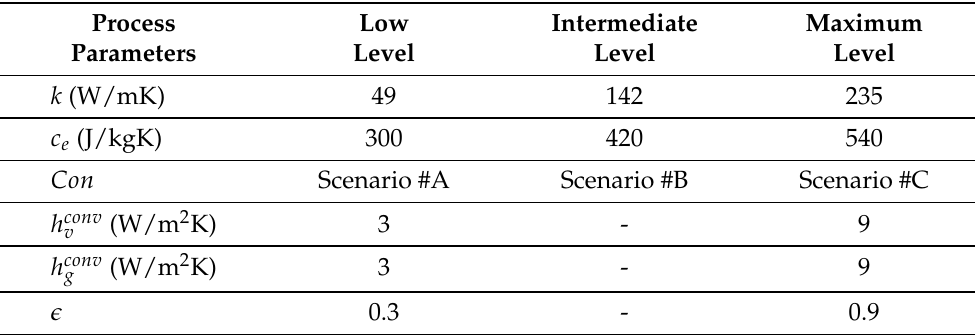
Table 2. Values of the analysed parameters for each level. Conductivity, specific heat and concavity have three levels, whereas both convective parameters and emissivity have only two. The steel density was considered constant with a value of 7900 kg/m 3 .